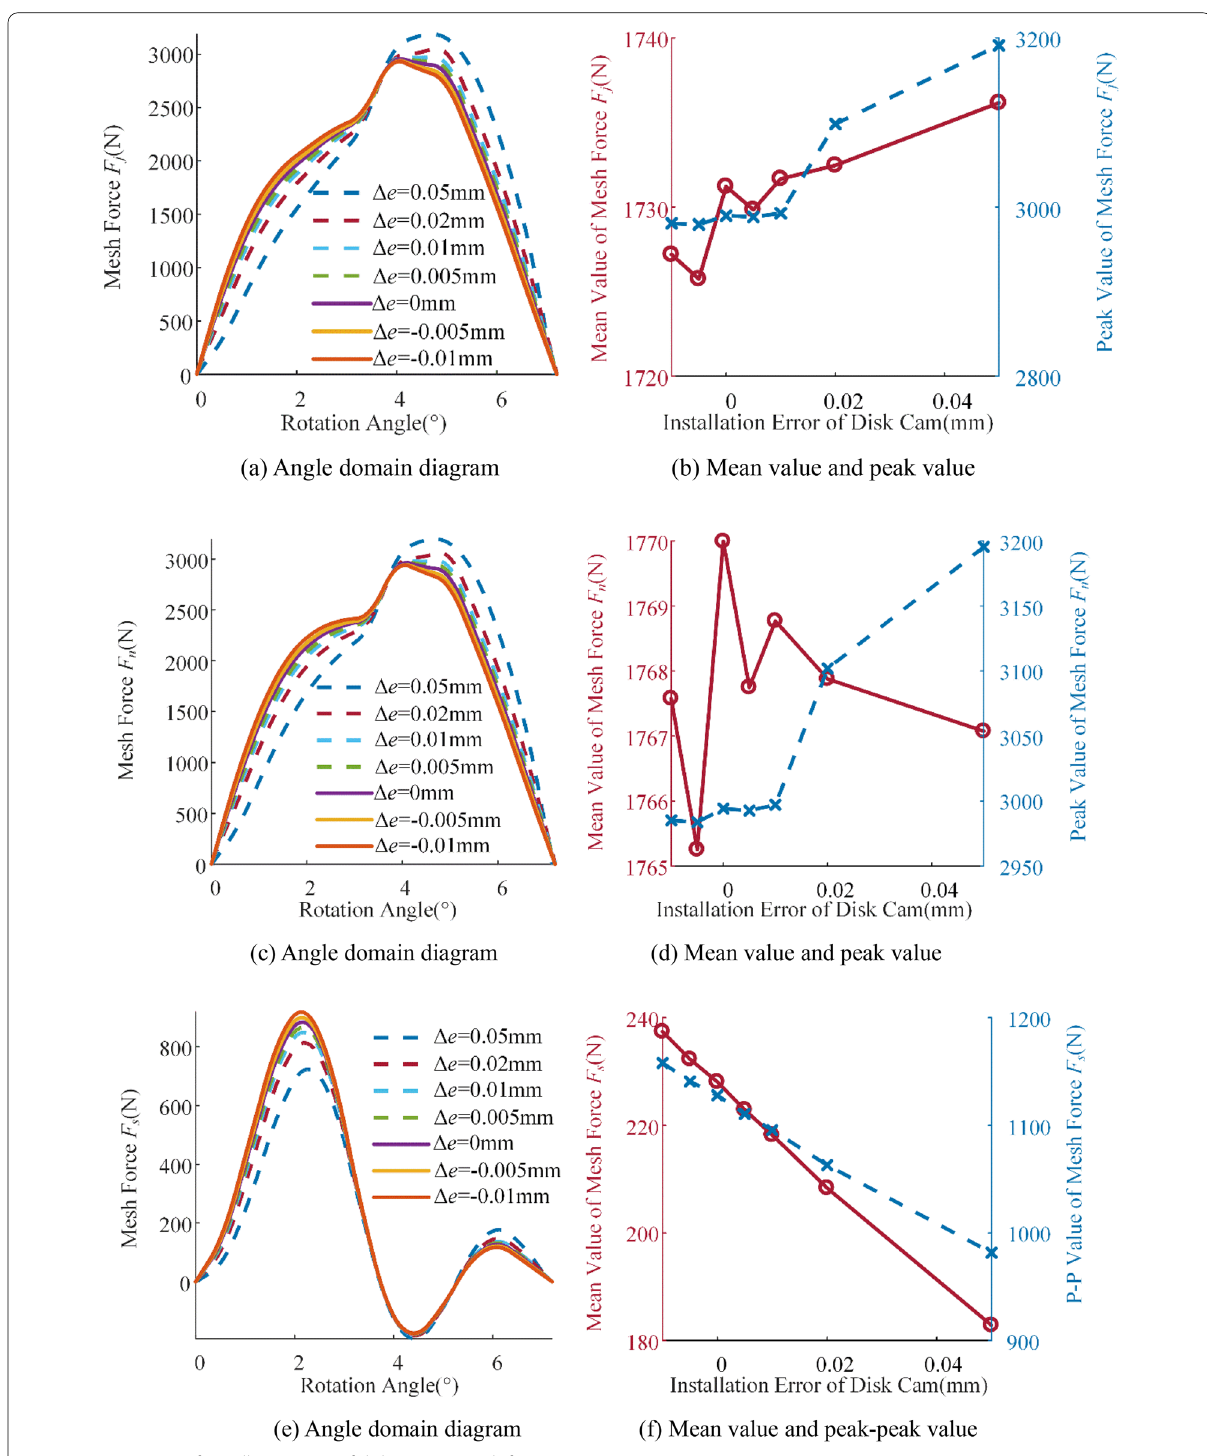
Figure 15 Impacts of installation error of disk cam on mesh